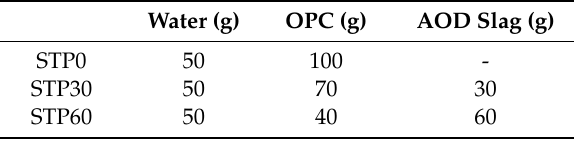
Table 2. Mixture proportions of the paste specimens.